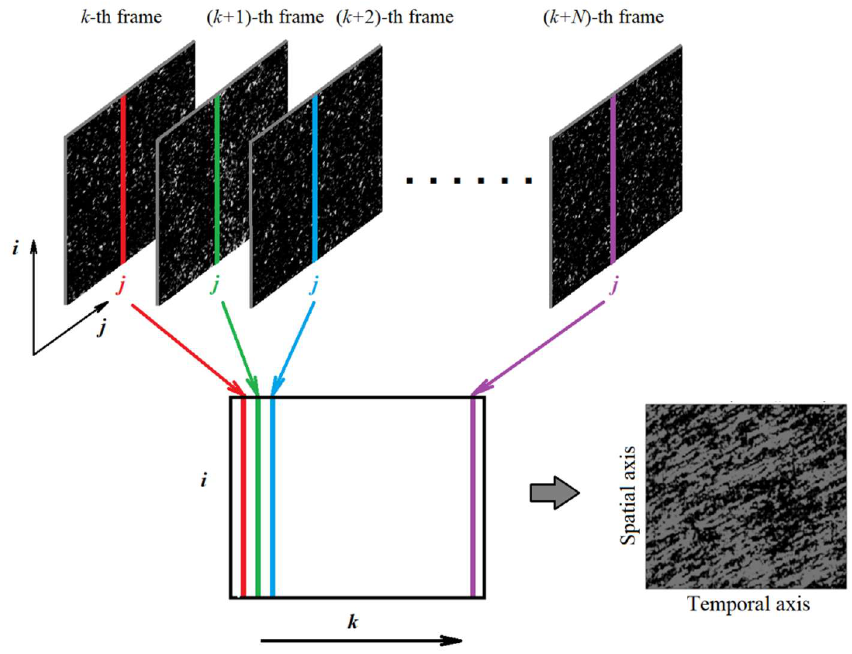
Figure 3. Recovery of a SSH map.